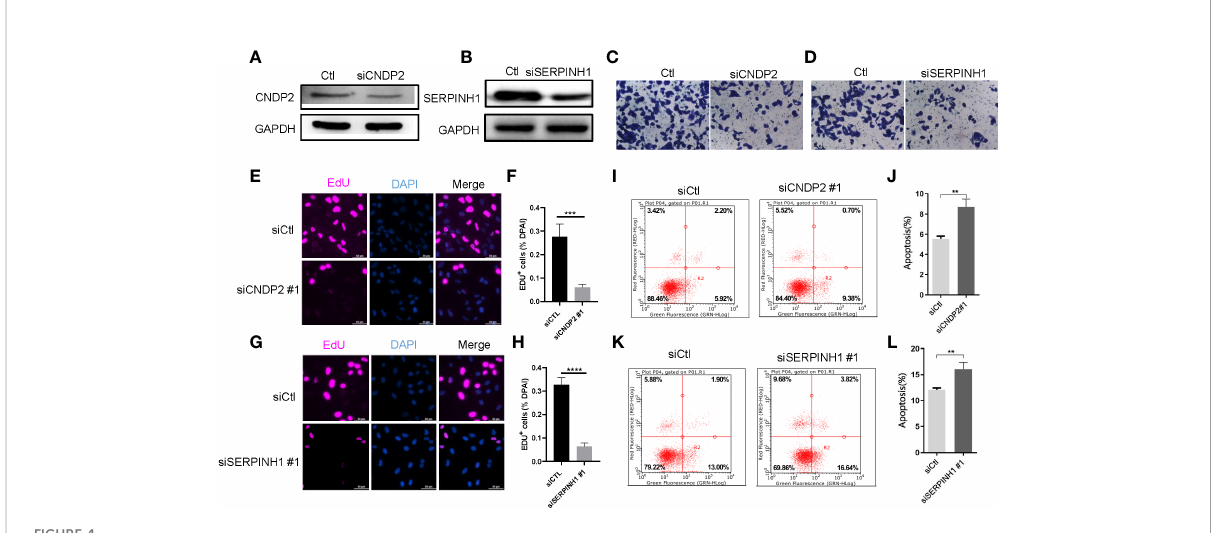
FIGURE 4 CNDP2 and SERPINH1 promotes prostate cancer cell proliferation, migration, and invasion. (A, B) Western blot assay showing that si CNDP2 and si SERPINH1 were obviously reduced at the protein level. (C, D) Transwell invasion assay showing that CNDP2 and SERPINH1 increased LNCap cell invasion. (E – H) EdU assay showing that CNDP2 and SERPINH1 increased LNCap cell proliferation ( P< 0.001). (I – L) Apoptosis assay showing that CNDP2 and SERPINH1 reduced LNCap cell apoptosis. ** P < 0.01, *** P < 0.001, *** P<